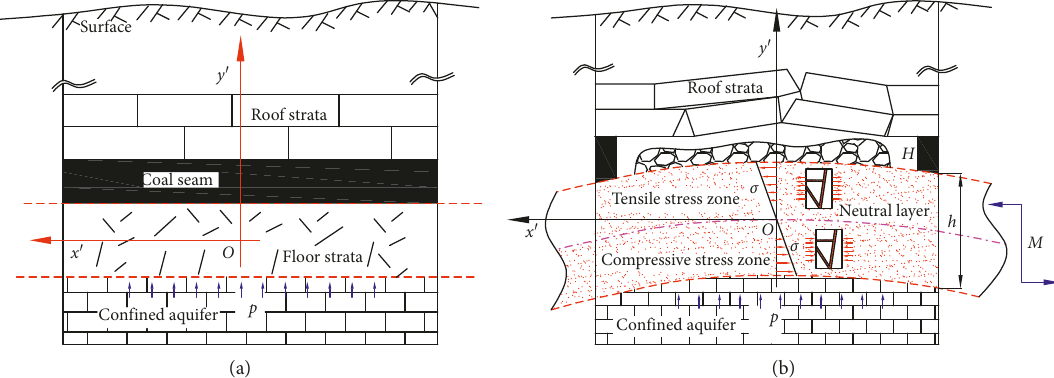
Figure 9: Schematic diagram of rock strata without grouting reinforcement (a) before coal seam mining and (b) after coal seam mining.